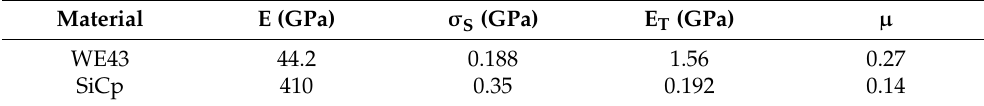
Table 1. Mechanical parameters of the matrix alloy and SiCp particle [3,12,20].